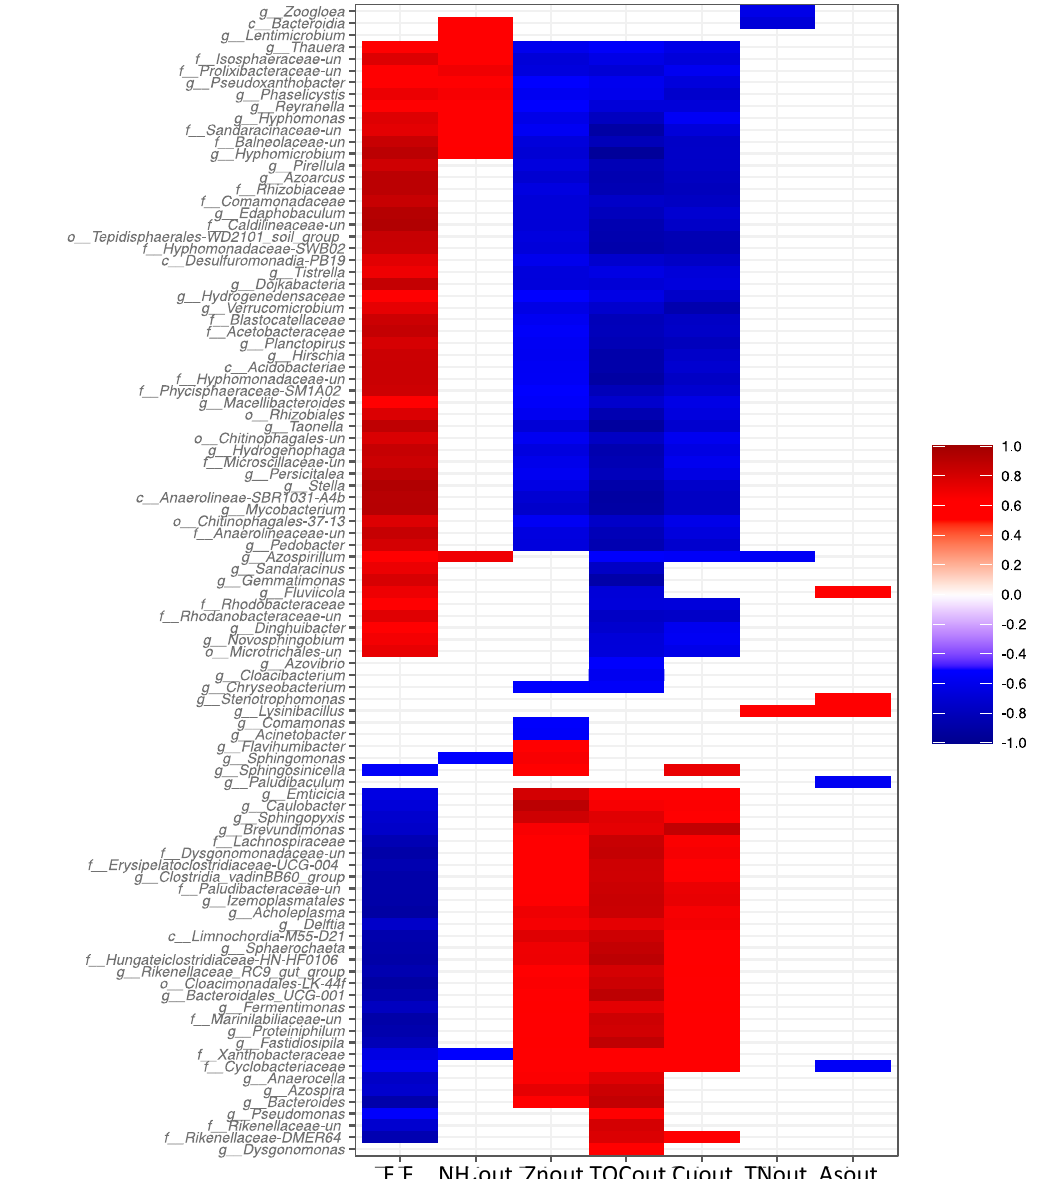
Figure 5. Spearman’s rank correlations are observed between relevant reactor operational variables and bacteria genera. Only taxa with at least a relative abundance >1% are shown. F v F m : ratio of variable to maximum fluorescence, (NH 4 -Zn-TOC-Cu-TN and As) out: ammonium, zinc, total organic carbon, copper, total nitrogen and arsenic concentration in the effluent. Only correlations that are significant (adjusted p -values < 0.05) are shown. See Supplementary Table S7 for full results. g__uncultured corresponds to uncultured or unknown